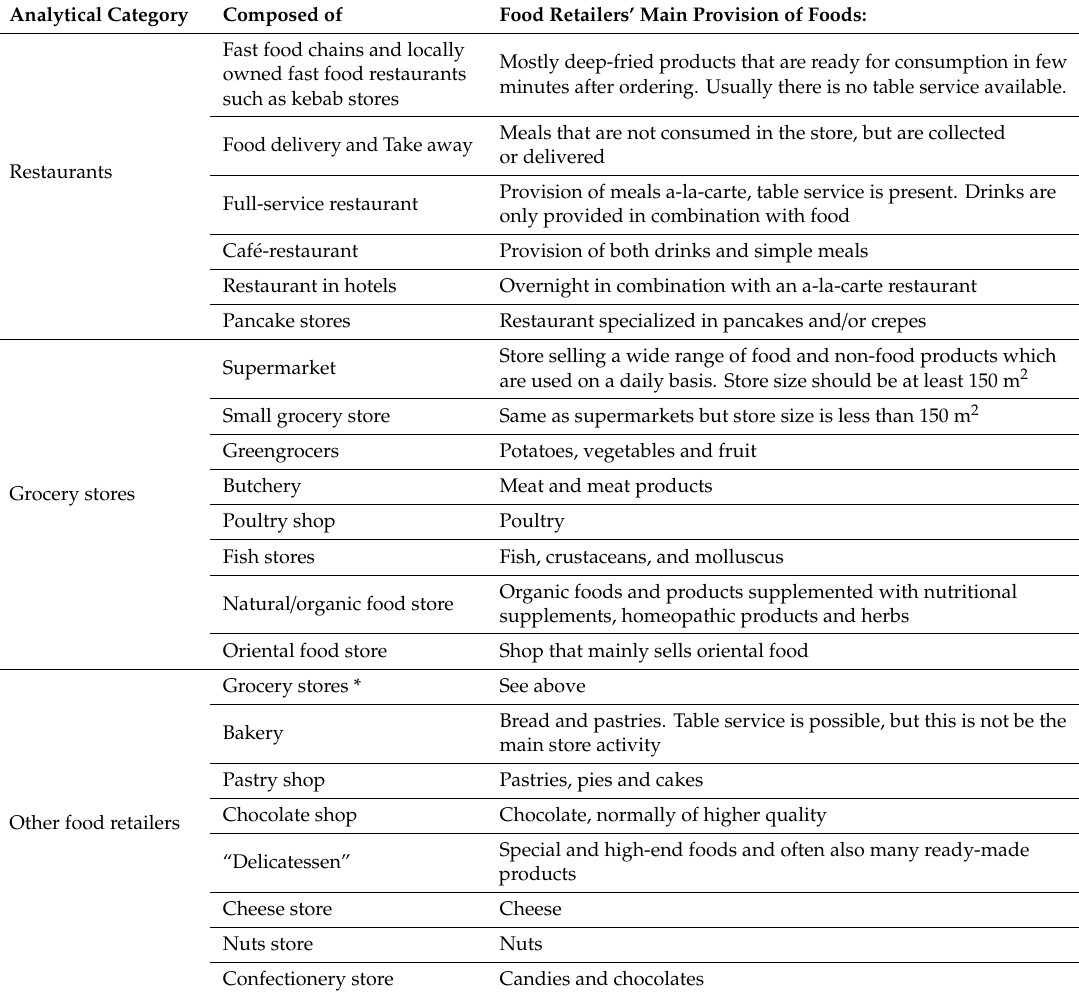
Table 1. Categories and definitions of food retailers analyzed. Definitions are as established by Locatus, the dataset